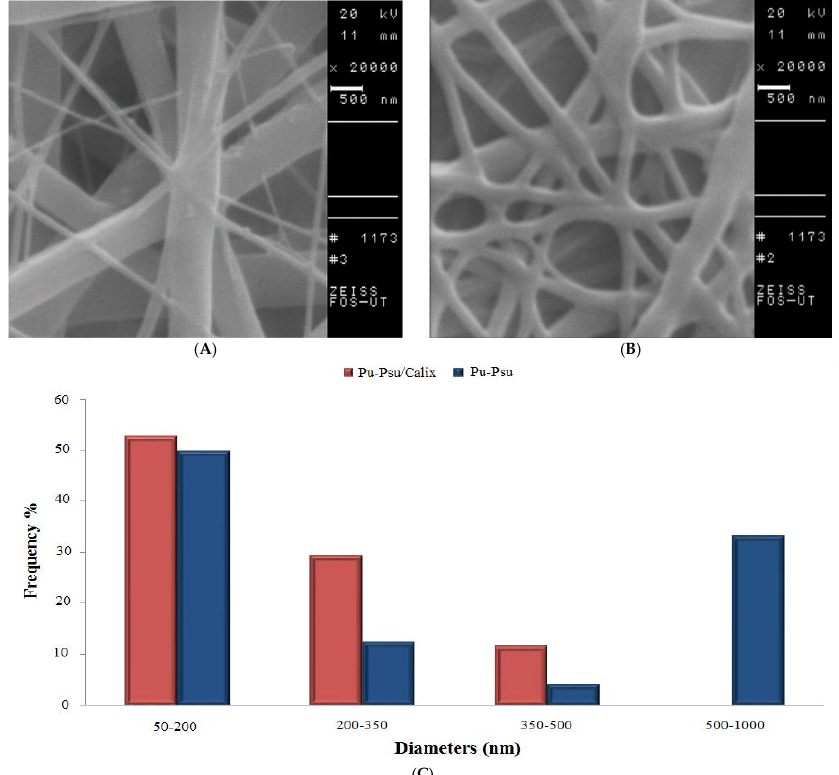
Figure 4. SEM micrograph of ( A ) PU–PSU nanofiber, ( B ) calix[4]arene modified PU–PSU nanofiber, and ( C ) fibers diameter histogram.